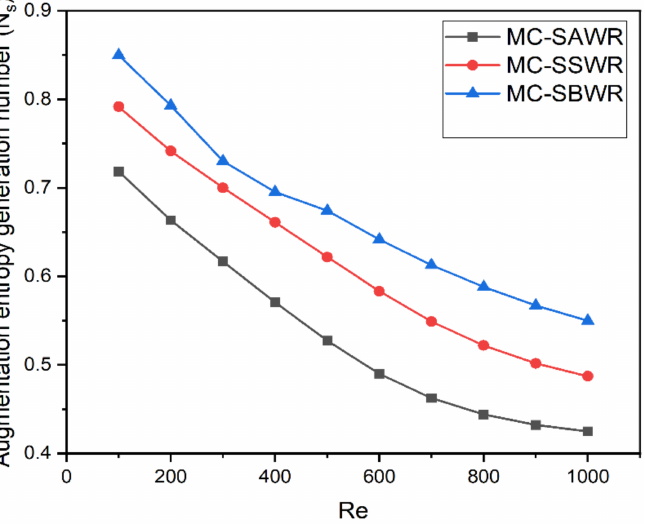
Figure 20. Variation of augmentation entropy generation number ( N s ) with Re for various MCHS